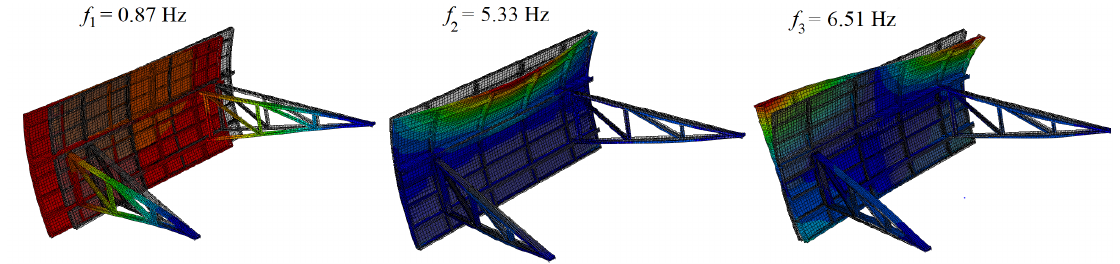
Figure 4. Example: First three modal shapes and frequencies of fictitious radial flood gate adapted from Bruscewicz et al. [2], with permission from Sciendo, 2020. Modal periods include the effects of fluid–structure